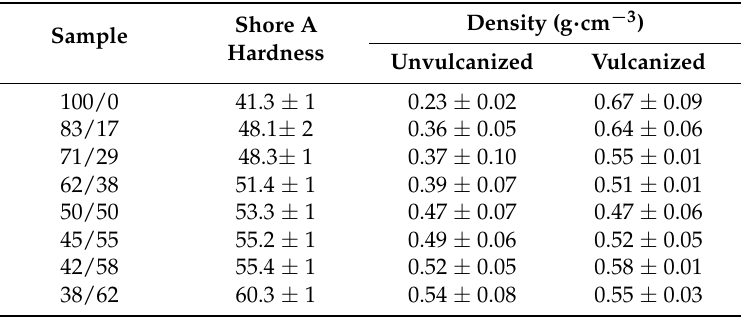
Table 4. Hardness and density of the analyzed